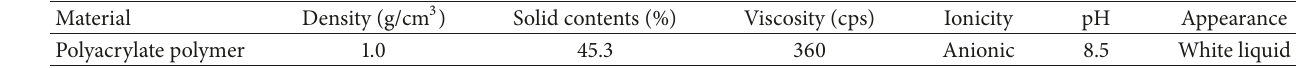
Table 1: Properties of polyacrylate polymer.